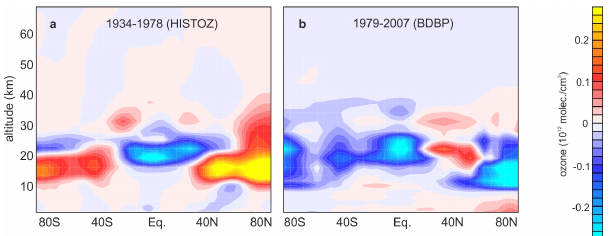
Figure 11. Differences in Jan-Mar averages of zonal mean ozone for El Niño minus La Niña winters (see Table 3) for the pre-1979 period (a, based on HISTOZ.1.0) and the post-1979 period (b, BDBP). Percentage deviations are shown in Fig. S10.